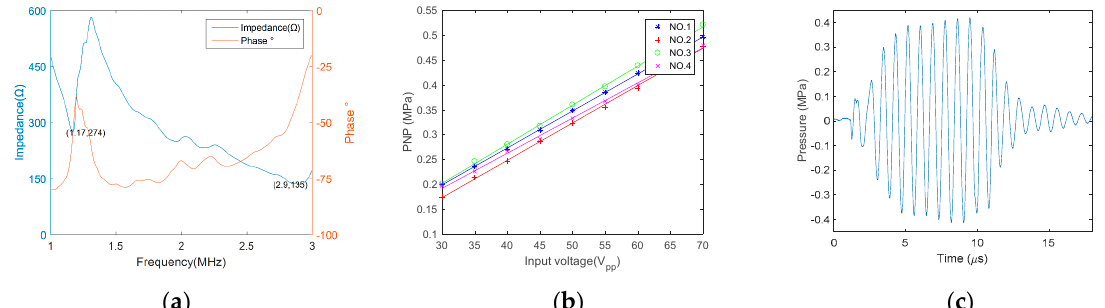
Figure 6. ( a ) Impedance amplitude and phase curves of ultrasound transducer. ( b ) Peak negative pressure conversion profile of transducers in one ultrasound-based prototype catheter. Distance of each transducer to the hydrophone is 2 mm. The fitted formula for each transducer is (1) y = 0.0074x − 0.0243, R 2 = 0.9999; (2) y = 0.0075x − 0.0518, R 2 = 0.9988; (3) y = 0.0079x − 0.0334, R 2 = 0.9992; (4) y = 0.071x − 0.0199, R 2 = 0.9984. ( c ) Time domain waveform of acoustic pressure. Table 2. The averaged values for acoustic parameters over the transducers. Parameter PNP: peak negative pressure; I SPPA : spatial peak pulse average intensity; I SPTA : spatial peak tem- poral average intensity; MI: mechanical index; Test condition: 1.1 MHz, 60 V pp , 500 Hz PRF, 10 bursts.